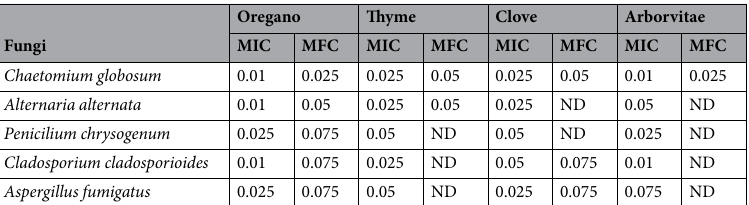
Table 2. Minimal inhibitory concentrations (MIC) and minimal fungicidal concentrations (MFC) (% w/v) of oregano, thyme, clove, and arborvitae EOs against the tested fungal strains. Each value is the mean of triplicate assays, ND – not